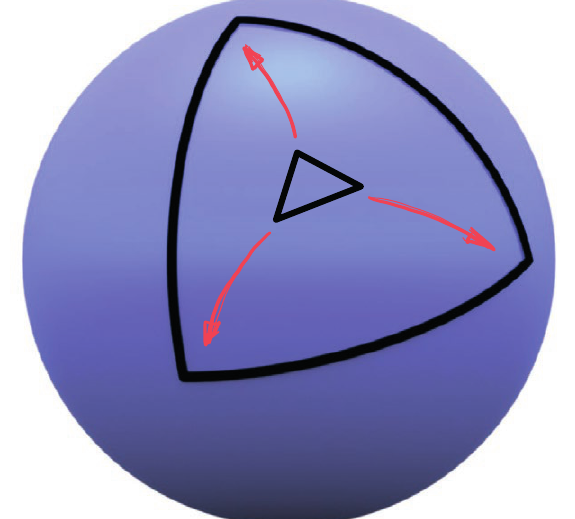
Figure 15. A fl at euclidean triangle placed on the sphere builds a spherical triangle, whose vertex angles add up to an angle exceed- ing to 180°: the example shown has an angle sum of 270°. Figure courtesy Myfanwy Evans.